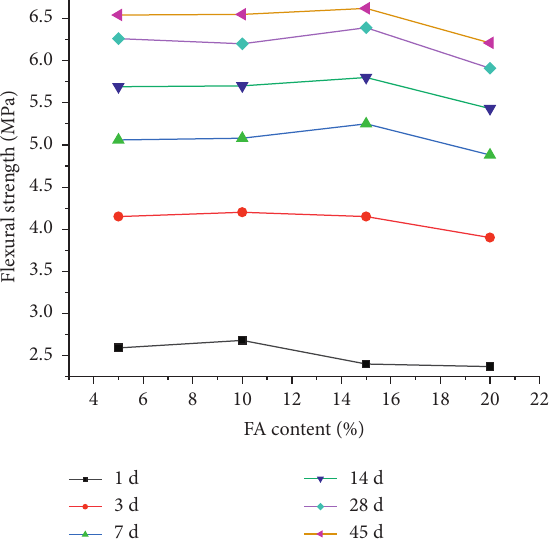
Figure 5: Influence of FA content on concrete flexural